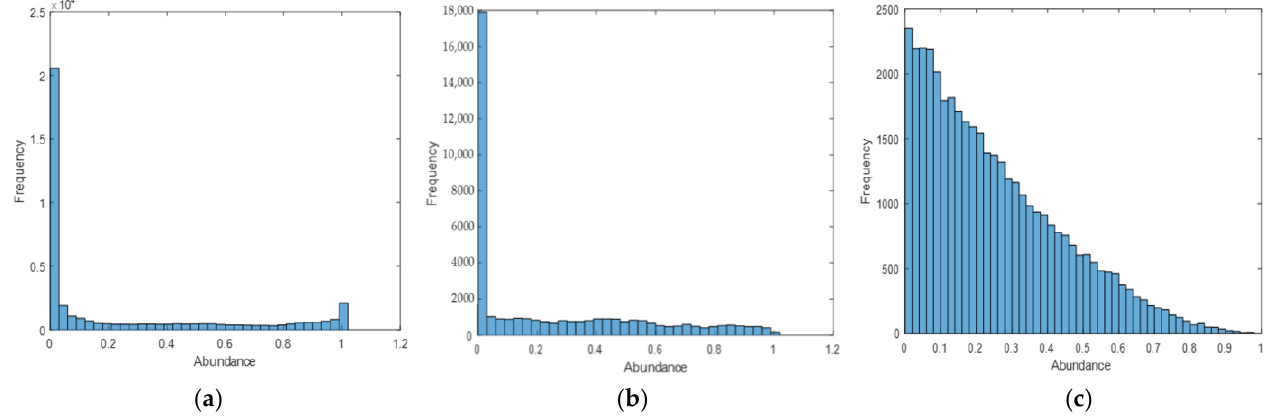
Figure 2. Histogram distribution of abundance of ( a ) Jasper Ridge; ( b ) data generated by the method we use; ( c ) data generated by Dirichlet distribution.